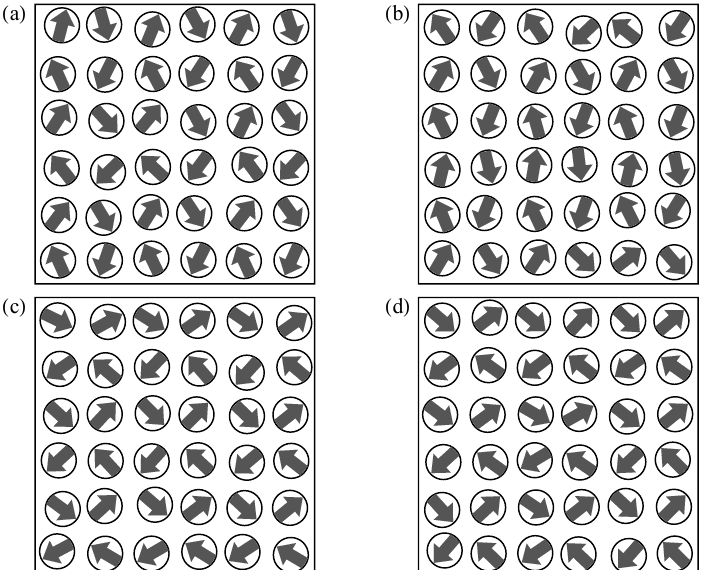
Figure 1. Ground-state magnetic configurations of four representative weakly-disordered square- lattice ensembles ( a – d ) having σ r = 0.05 r 0 . The positions of the MNPs within the unit cell are indicated by the disks and the directions of the magnetic moments by the arrows. Notice that all ground-state magnetic configurations correspond to a microvortex state with different angles α MV [see Equation